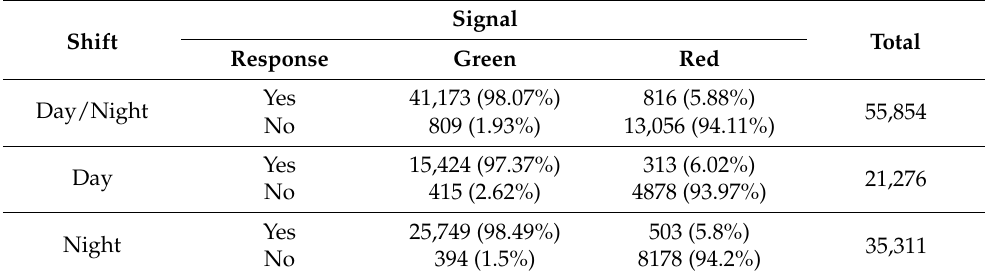
Table 7. Results of the SDT Analyses. Shift